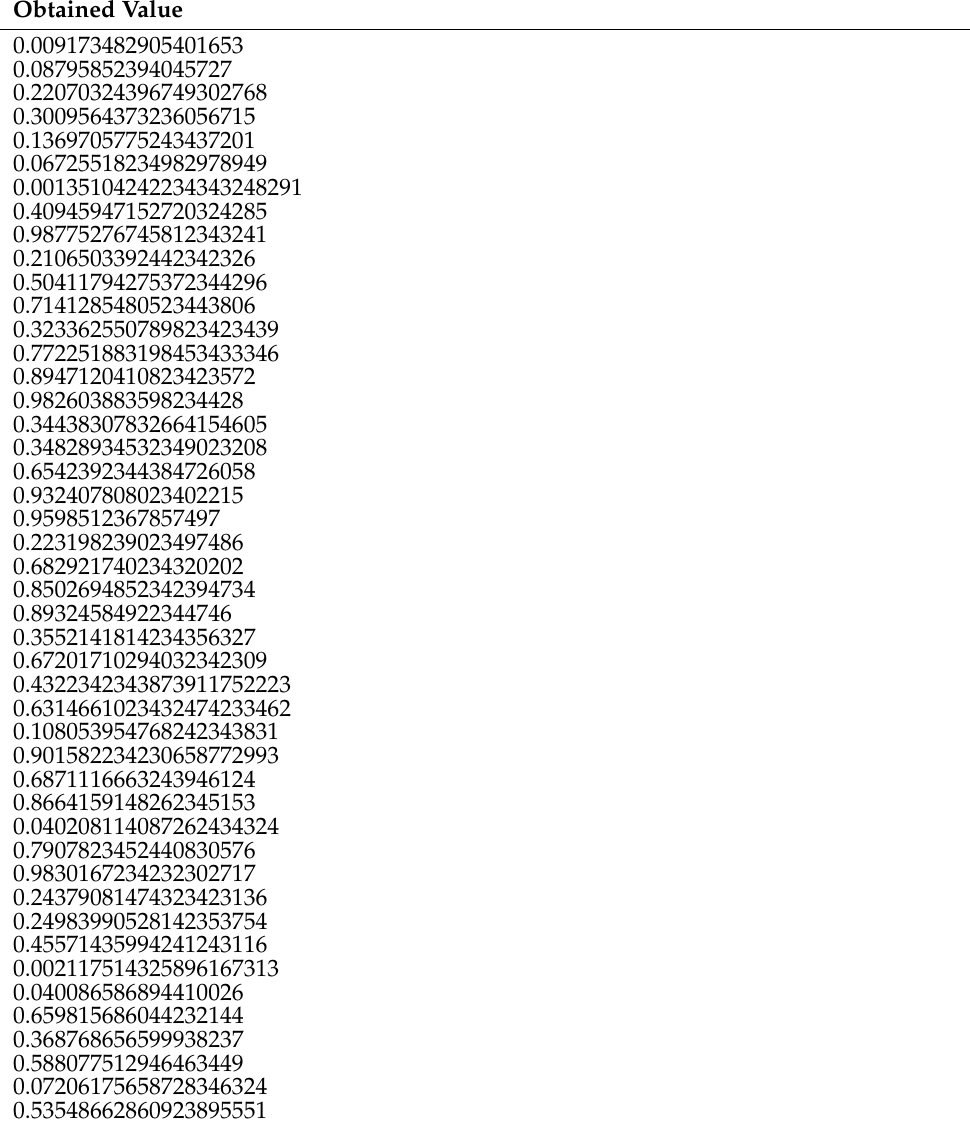
Table 1. Sample of a sequence of signal intensities captured as output and normalized by the MinMaxS- caler